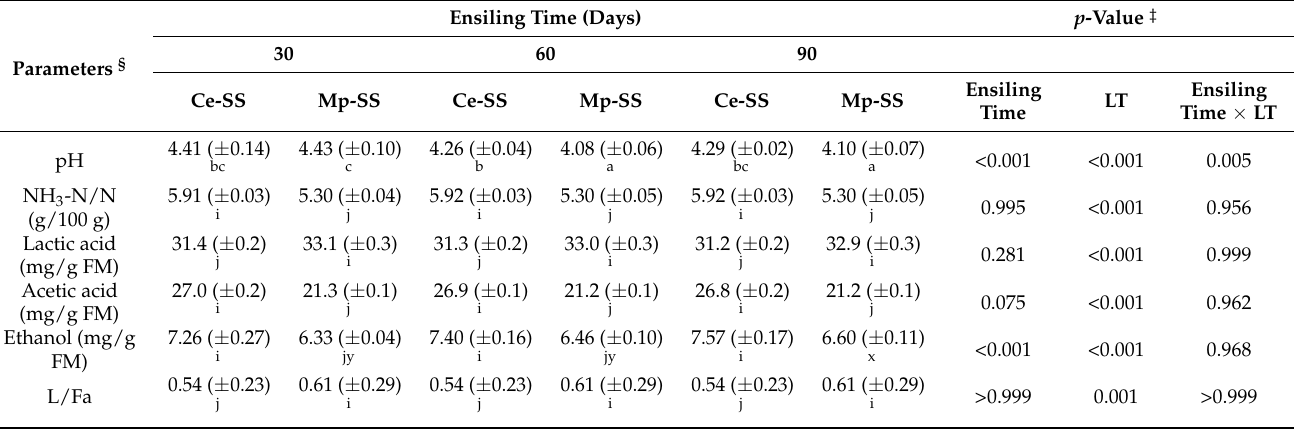
Table 3. Mean ( ± standard deviation) of ensiling fermentation characteristics of mixed C. ensiformis (Ce) or M. pruriens (Mp) beans meal with sugarcane stalks (SS) ensiled for 30, 60 or 90 days ( n = 3).